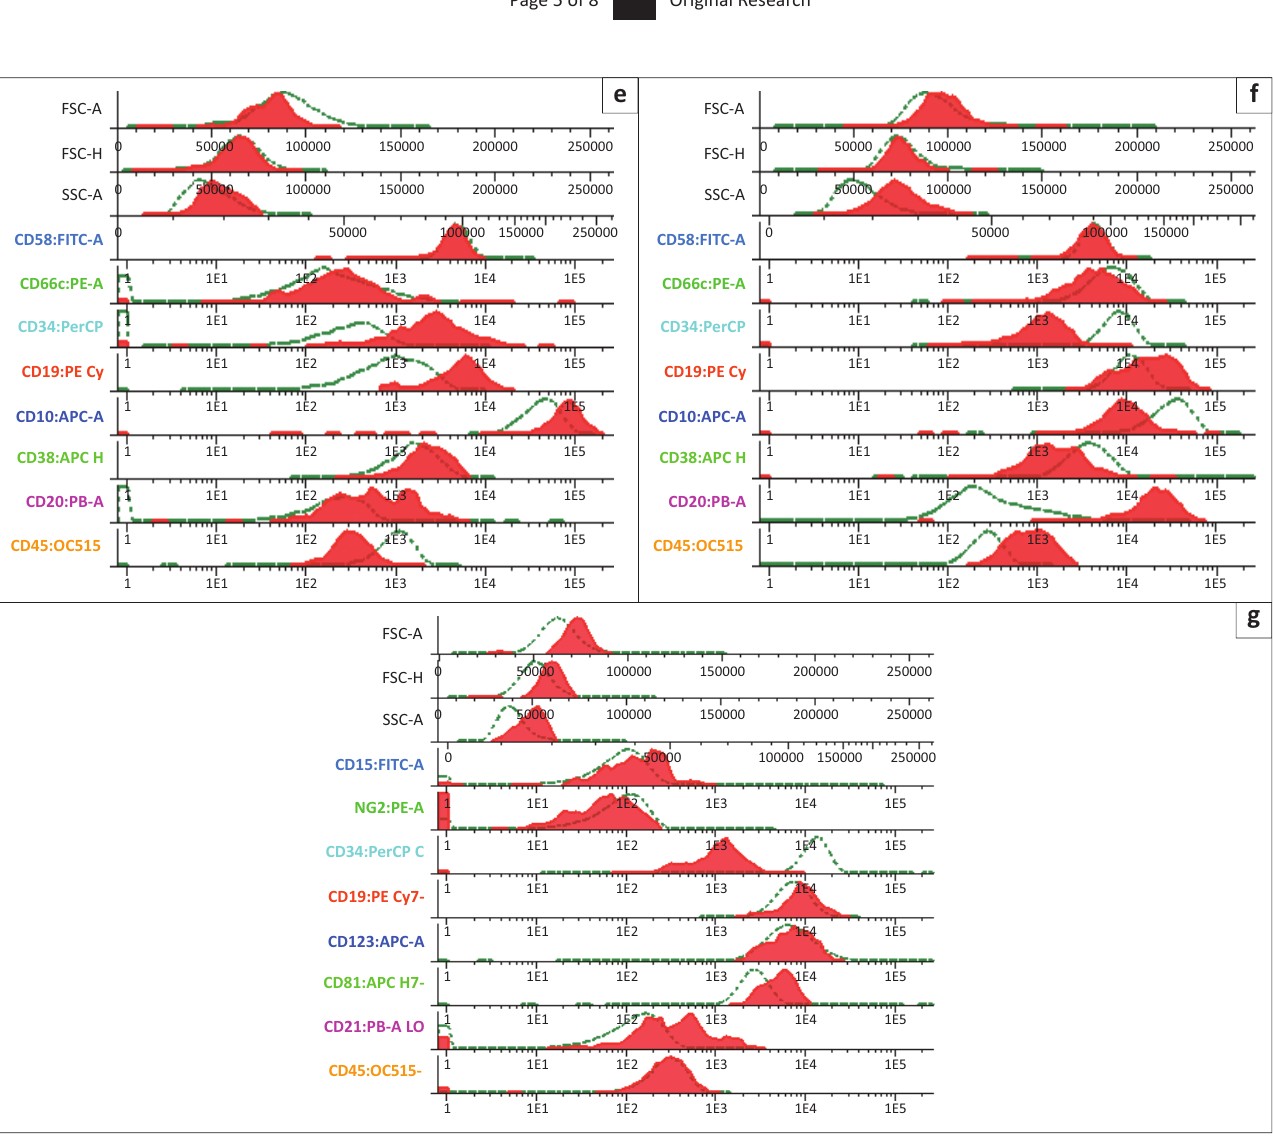
MRD, Minimal residual disease. FIGURE 3 (Continues...): Histograms illustrating patients with flow minimal residual disease positivity. (a) flow MRD pos: t (12;21) pos; (b) flow MRD pos: t (1;19) pos; (c) flow MRD pos: hyperdiploidy; (d) flow MRD pos: hyperdiploidy; (e) flow MRD pos: t (1;19) pos; (f) flow MRD pos: hyperdiploidy with antigenic shifts; (g) flow MRD positive (monoclonal